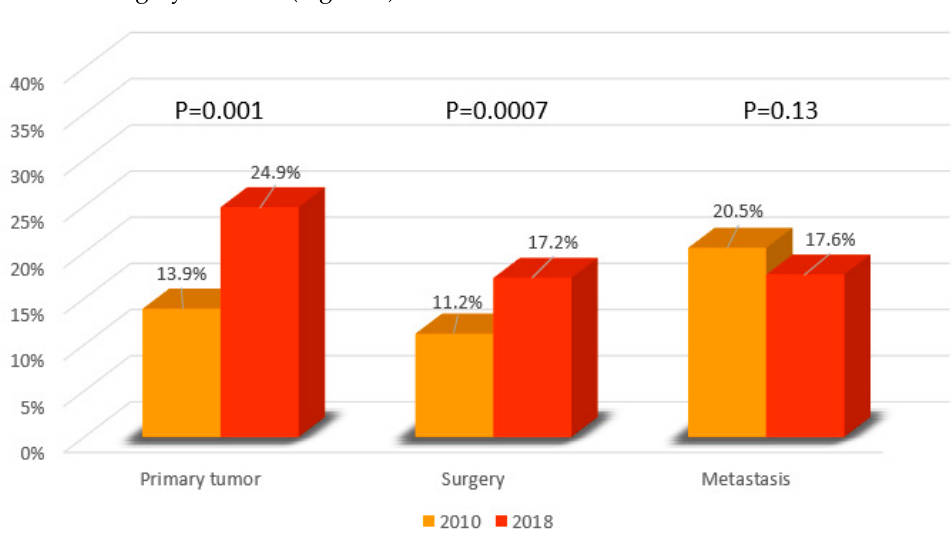
Figure 4. Type of diagnostic microscopic confirmation in 2010 and 2018 in PC patients in the Veneto region population (percentage expressed on total PC cases of the referral year).